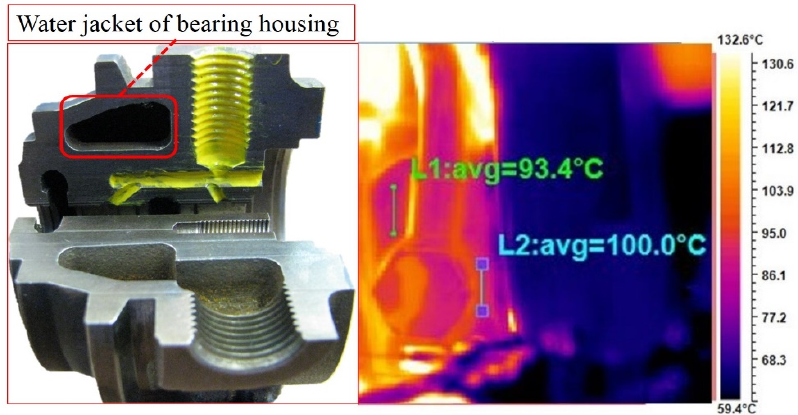
Figure 8. Turbocharger bearing system.